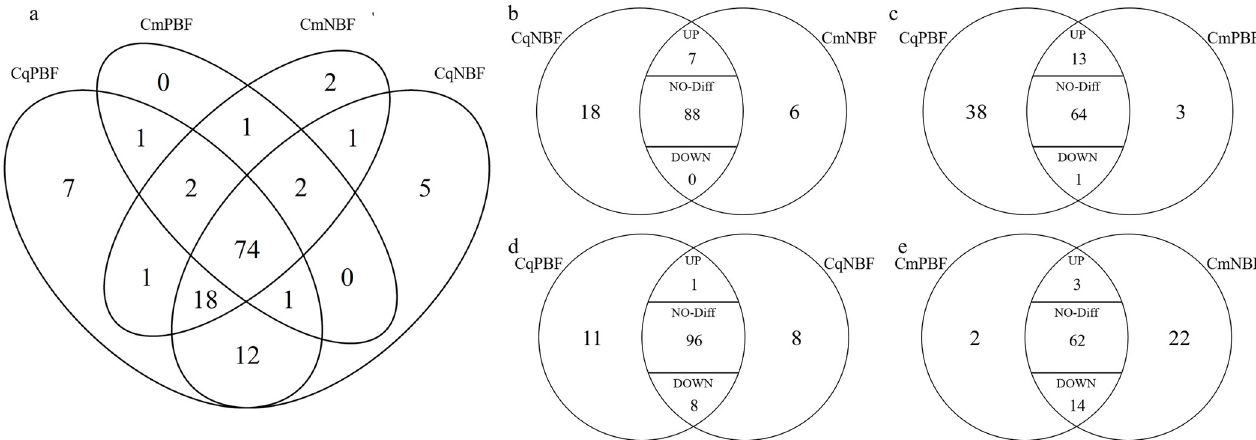
Fig 3. Venn diagrams of significantly differentially expressed OR genes. Fig 3A: OR genes intersections among 4 groups. Cq is short for Culex quinquefasciatus , and Cm is short for Culex molestus . NBF stands for non-blood-feeding, and PBF stands for post-blood-feeding. Fig 3B: significantly differentially expressed OR genes intersections between two subspecies before blood feeding: On the basis of the traditional venn diagram, we divided the overlapping Olive-shaped region into 3 sections “up, no-diff and down”. The X in “up” section means there were X genes significantly up-regulated when the two groups were compared. For example, there were 95(7+88+0) genes both expressed in CqNBF and CmNBF, in which 7 genes were significantly up- regulated, 0 genes down-regulated and 88 genes with no difference in expression level; Fig 3C: significantly differentially expressed OR genes intersections between two subspecies after blood feeding; Fig 3D: significantly differentially expressed OR genes intersections of Cx . pipiens quinquefasciatus before and after blood feeding; Fig 3E: significantly differentially expressed OR genes intersections of Cx . pipiens molestus before and after blood feeding.